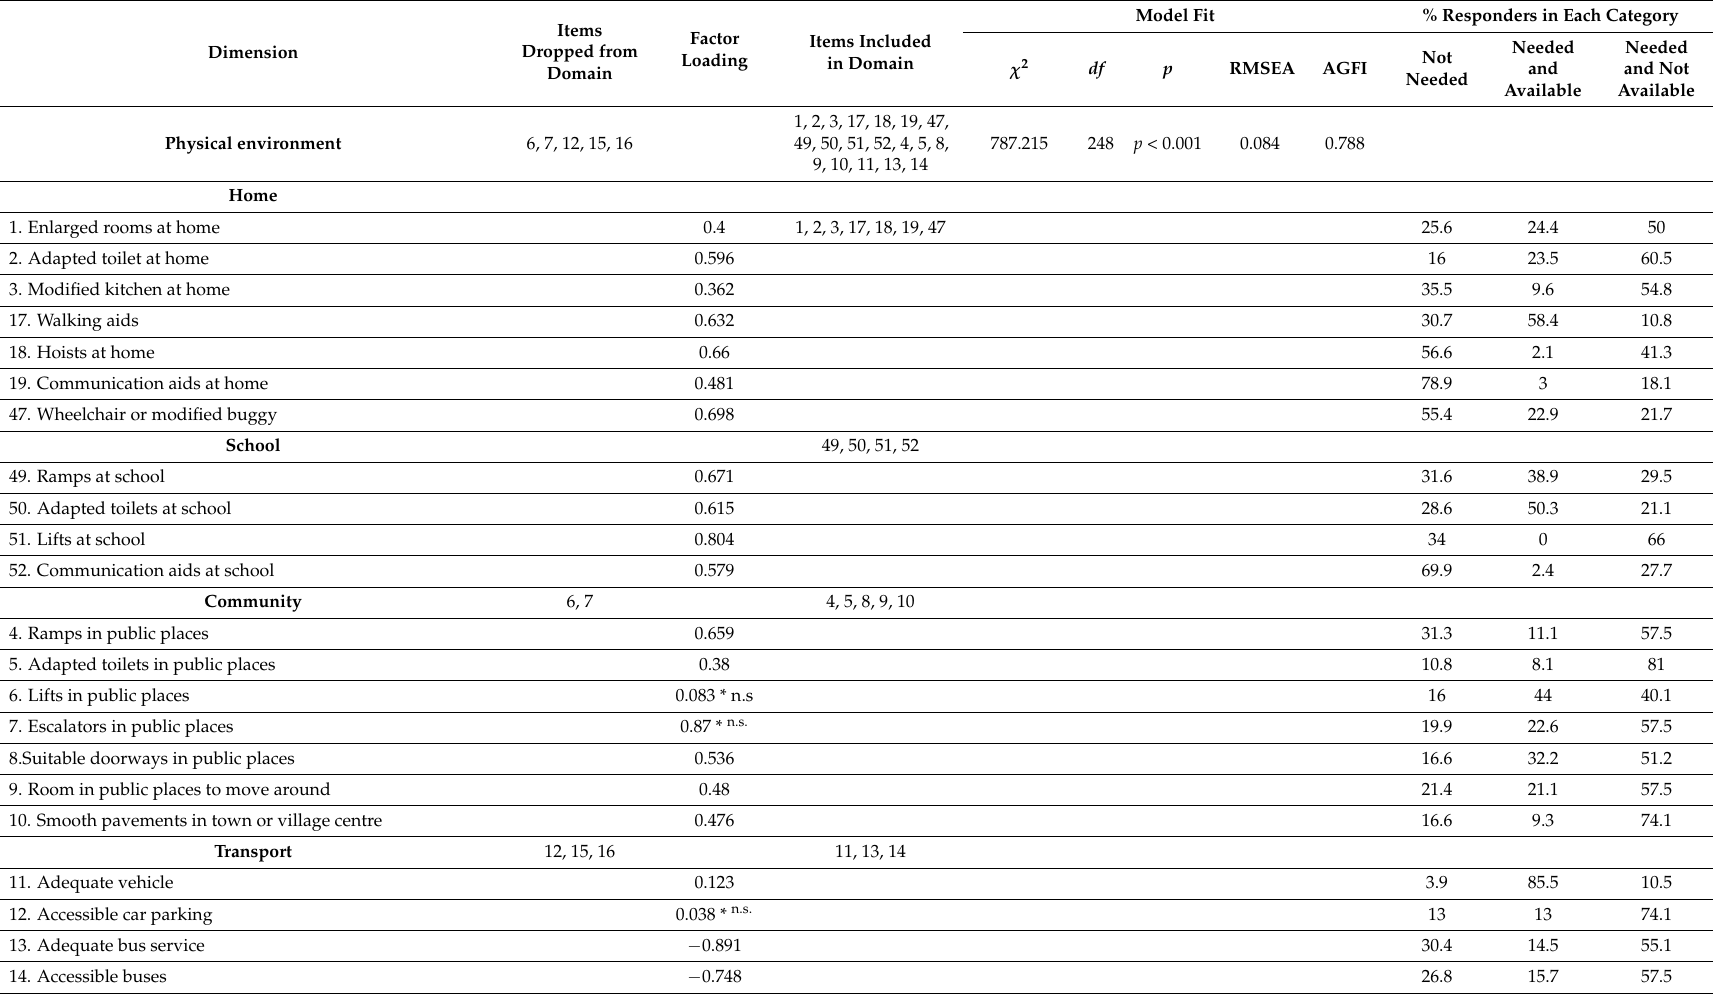
Table 3. Summary of responses and refinement of domain structure to ECEQ items by 332